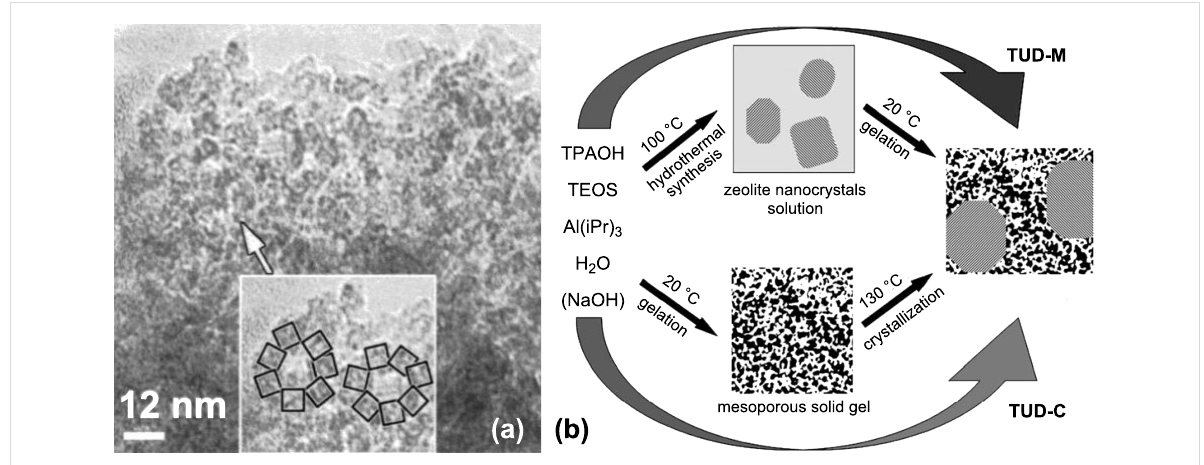
Figure 7: (a) Edge-sharing principle in the template-free synthesis in acidic medium [147] and (b) schematic representation of the TUD-C and TUD-M synthesis [152]. Reprinted from [147,152]. Copyright 2008 and 2009, with permission from Elsevier.